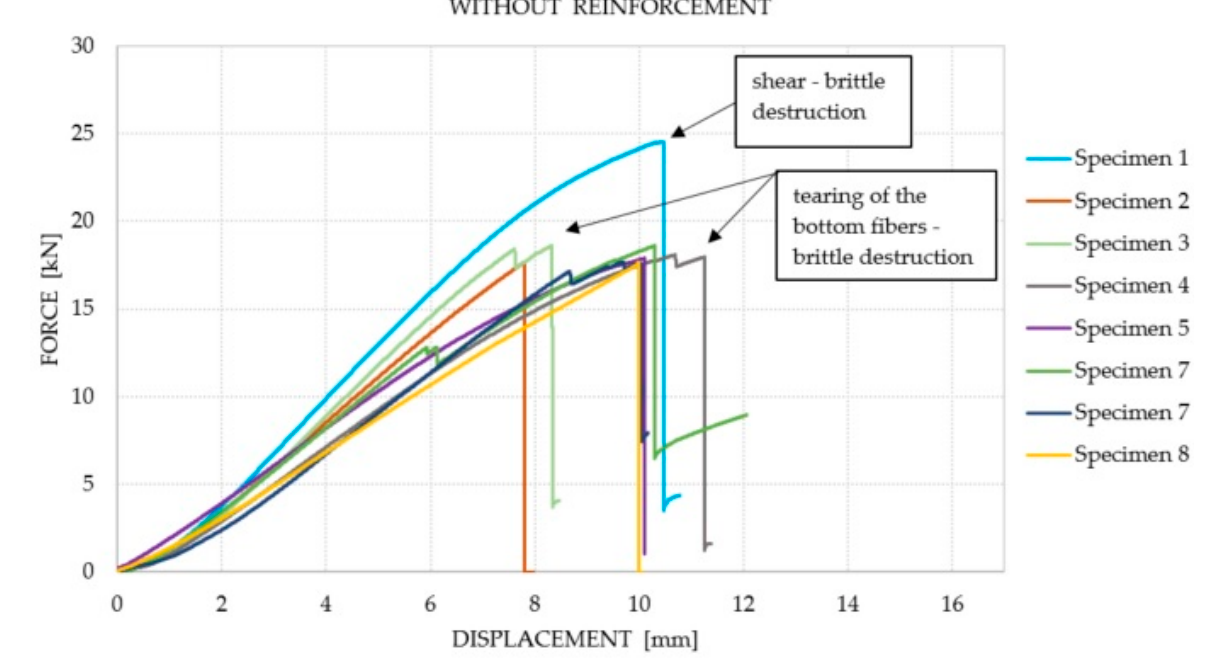
Figure 7. Force–displacement chart for the beams without reinforcement.